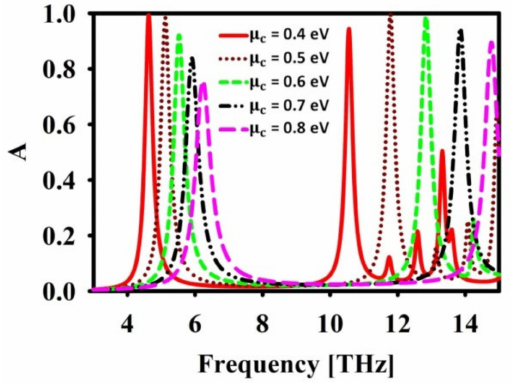
Figure 4. Effect of µ c in absorption (A) spectra.